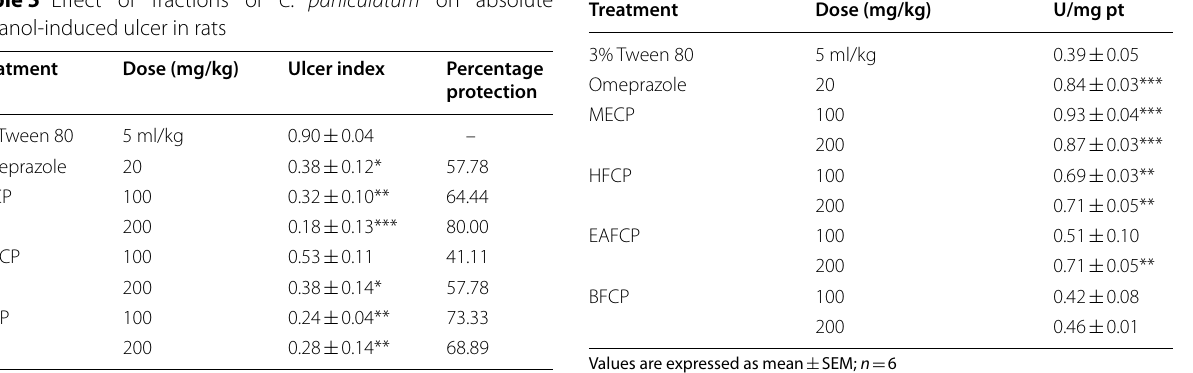
Values are expressed as mean HFCP n-hexane fraction, EAFCP ethyl acetate fraction, BFCP butanol fraction